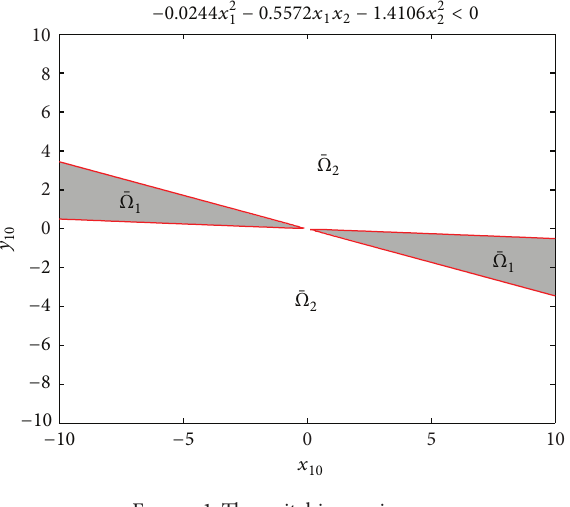
Figure 1: The switching regions. Table 1: Allowable delay upper bound for different decay rate with = 1 , 𝛼 = 𝛼 = 0.5 . 𝑑 𝑚 1 2